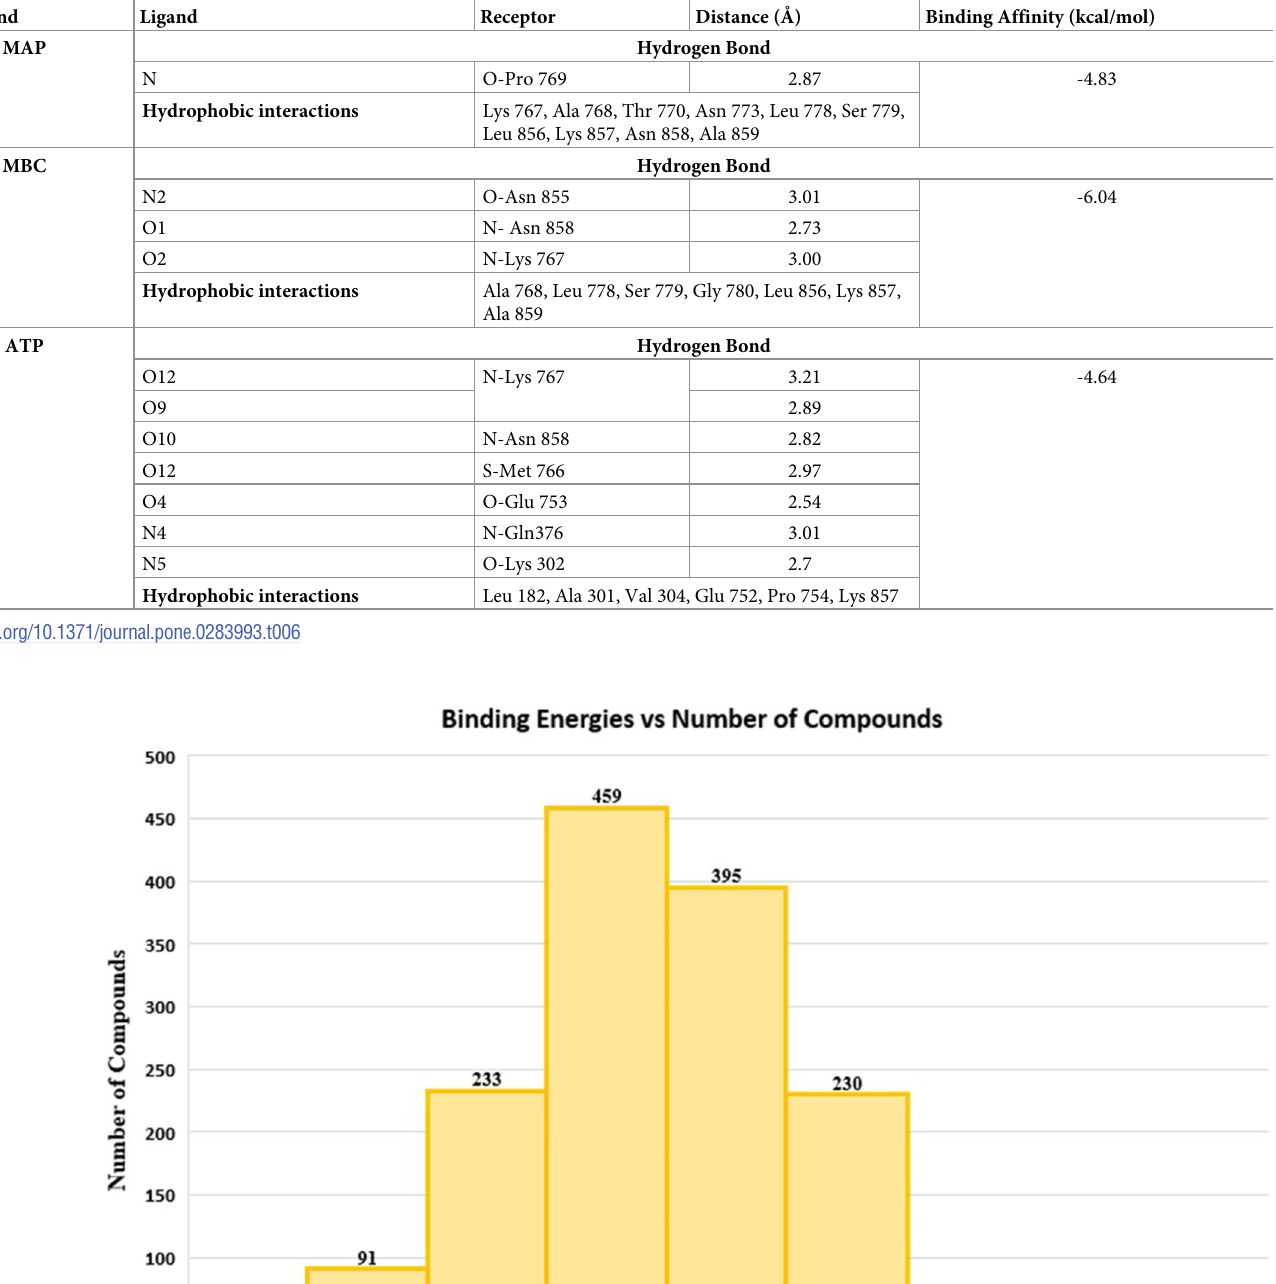
Table 6. Molecular Docking Analysis for reference compounds and substrates.